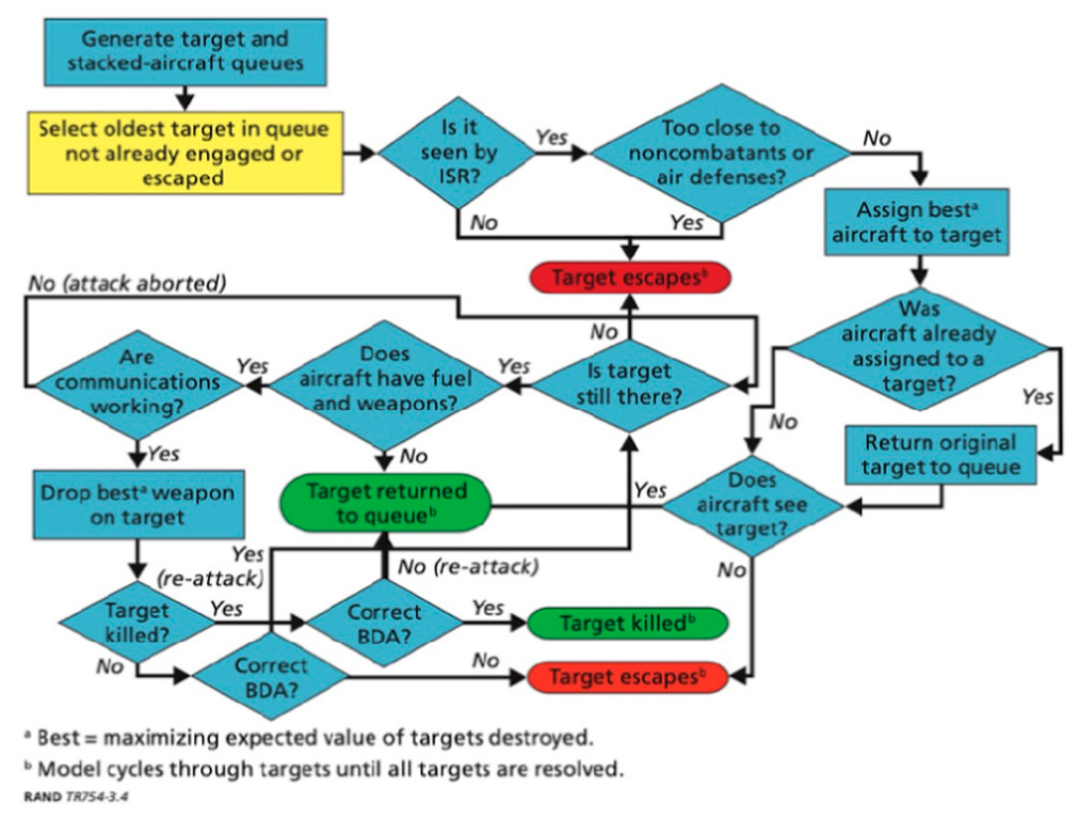
Figure 6. Schematic of the model. Source: [61].